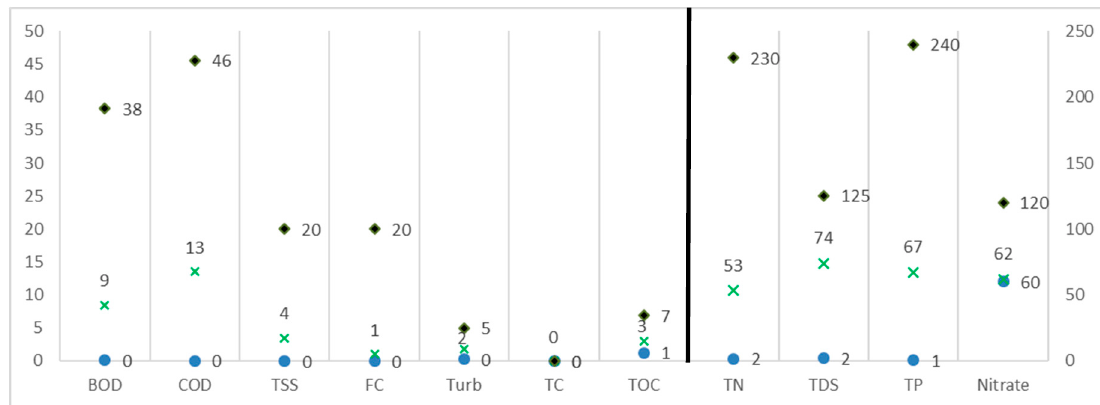
Figure 7. Plausibility check of the 13 simulations P1–13 results. The y -axis shows pollutant removal efficiencies (%) for the literature value ( ) and for the DST simulation operating under minimal ( ), average ( ) and maximal ( ) unit processes efficiencies.